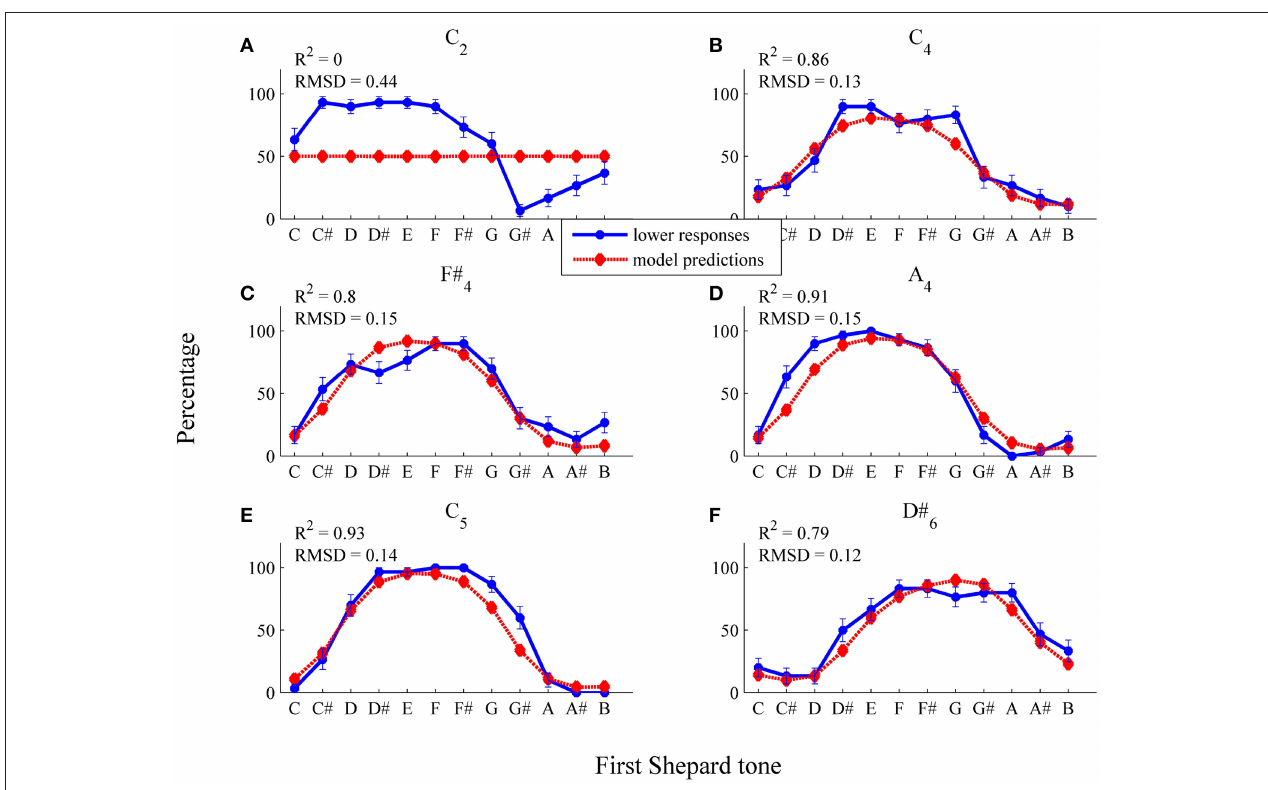
FIGURE 10 | Fitted pronounced pitch class effects (participant PG ): average percentages of lower responses (blue dots and unbroken line) in comparison to model predictions for the six envelopes (A) C 2 , (B) C 4 , (C) F # 4 , (D) A 4 , (E) C 5 , (F) D # 6 (red diamonds and dotted line; estimated model parameters: